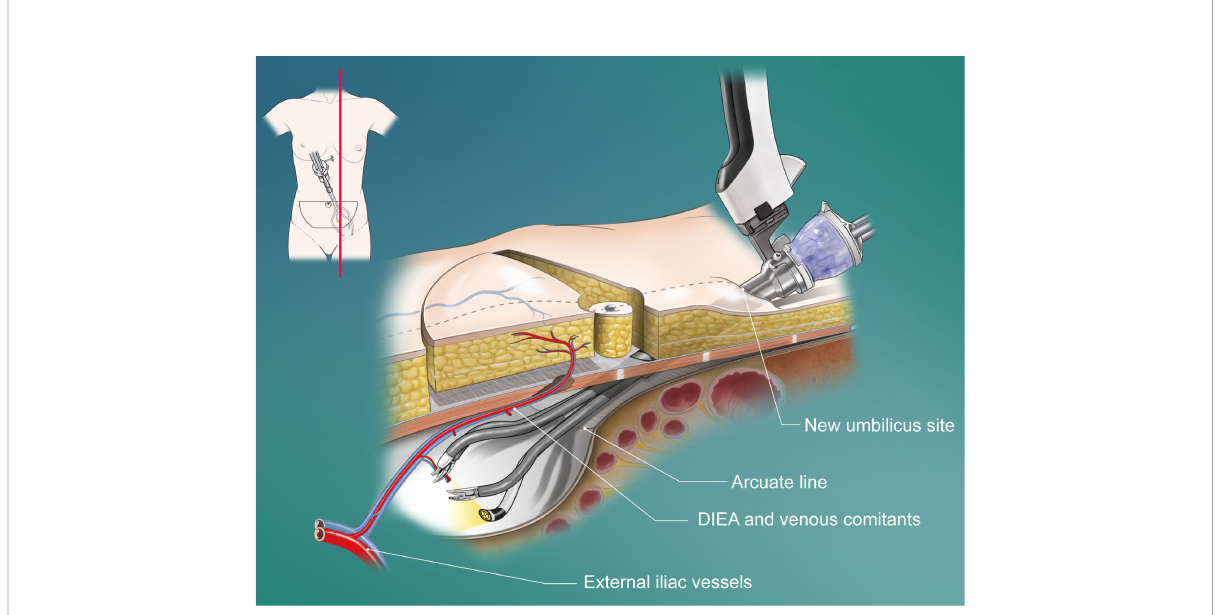
FIGURE 2 Schematic diagram of the penetrating placement of the single port in a robotic DIEP fl ap harvesting through a totally extraperitoneal approach. DIEA, deep inferior epigastric artery.